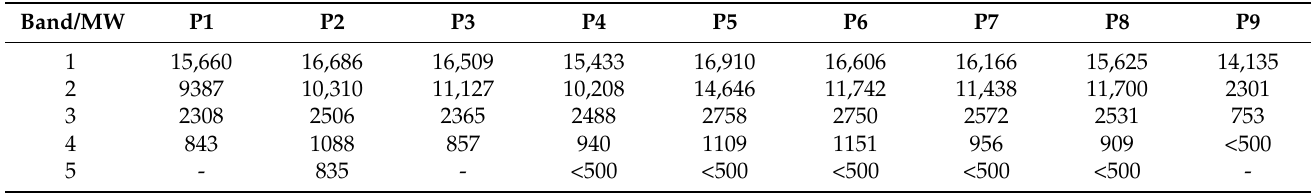
Table 3. Molecular weights (in Daltons) of identified fractions by